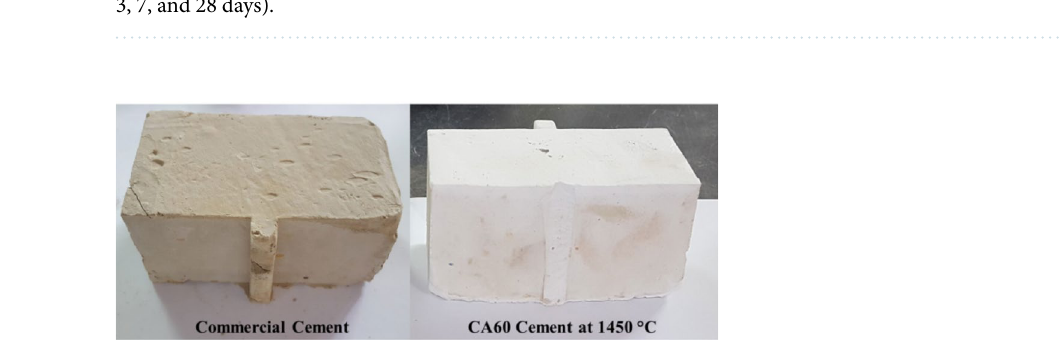
Figure 10. Manufactured CA60 sintered at 1450 °C and commercial cement pastes.